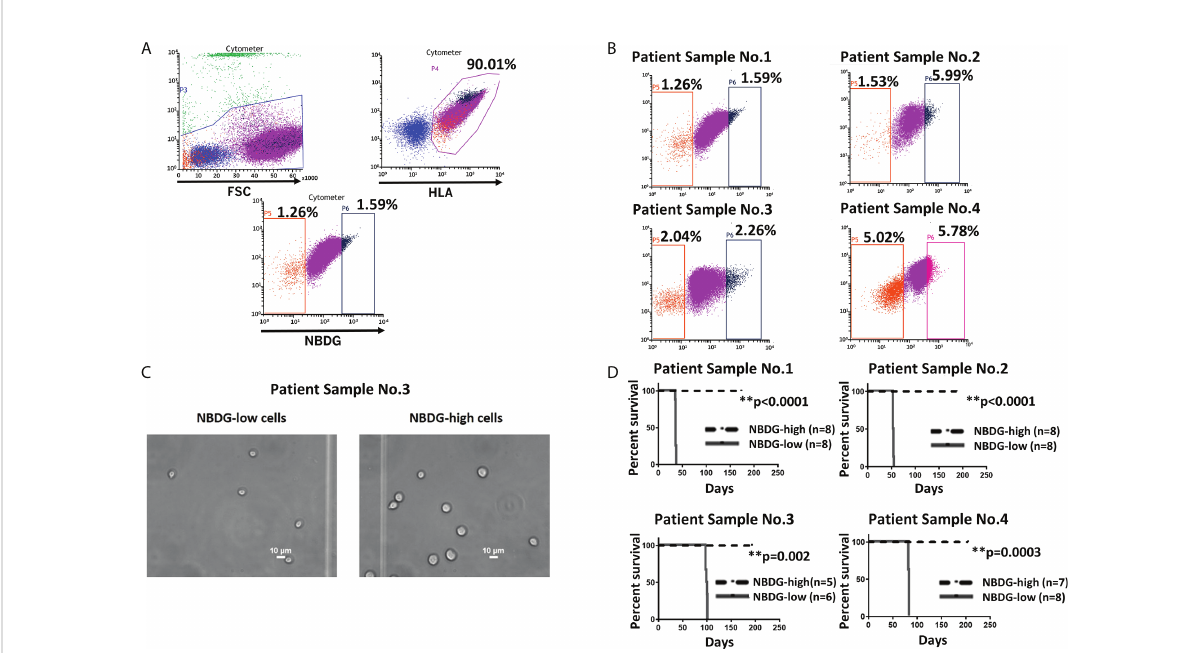
FIGURE 1 Identi fi cation of a distinct subset of B-ALL cells based on low glucose uptake and leukemia initiating capacity. (A) Gating strategy and sorting pro fi le of patient-derived B-ALL cells by NBDG are shown. After gating DAPI-negative and HLA-positive cells, a distinct population was identi fi ed from the rest of the population by NBDG uptake levels. Low-uptake NBDG cells (NBDG-low cells, orange dots) are smaller, HLA-dim, and a small population. In contrast, high-uptake NBDG cells are bigger, HLA-strongly positive, and a majority of the population. Very high-uptake NBDG cells (NBDG-high cells) (black dots) were used as the counterpart of NBDG-low cells. (B) The distinct population of NBDG-low cells is detected in different patient samples. (C) Phase microscopy pictures of NBDG-low and NBDG-high cells show NBDG-low cells are smaller than NBDG-high cells (example results of PS3 are shown). (D) All mice that were injected with NBDG-low cells, using four patient samples (PS1-4), developed leukemia while none of NBDG-high groups developed leukemia (p ≤ 0.0001-0.002). In four patient samples (PS1-4), transplanted cells ranged between 5,000 and 50,000 cells per mouse based on the available sorted cells at the time (PS1: 10,000 cells in three mice and 50,000 cells in fi ve mice. PS2: 5,000 cells in four mice and 10,000 cells in four mice. PS3:10,000 cells in six mice for NBDG-low and fi ve mice for NBDG-high. PS4:10,000 cells in eight mice). ** means